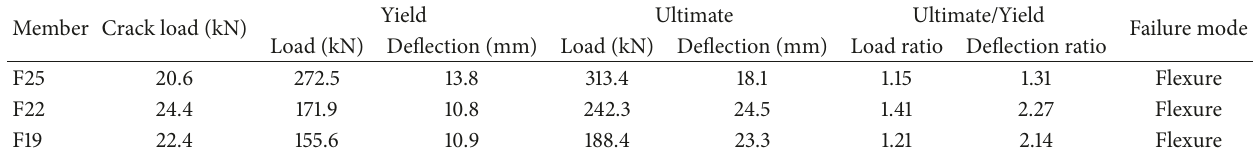
Table 4: Crack, yield and ultimate loads and corresponding center displacement of flexural test specimens.